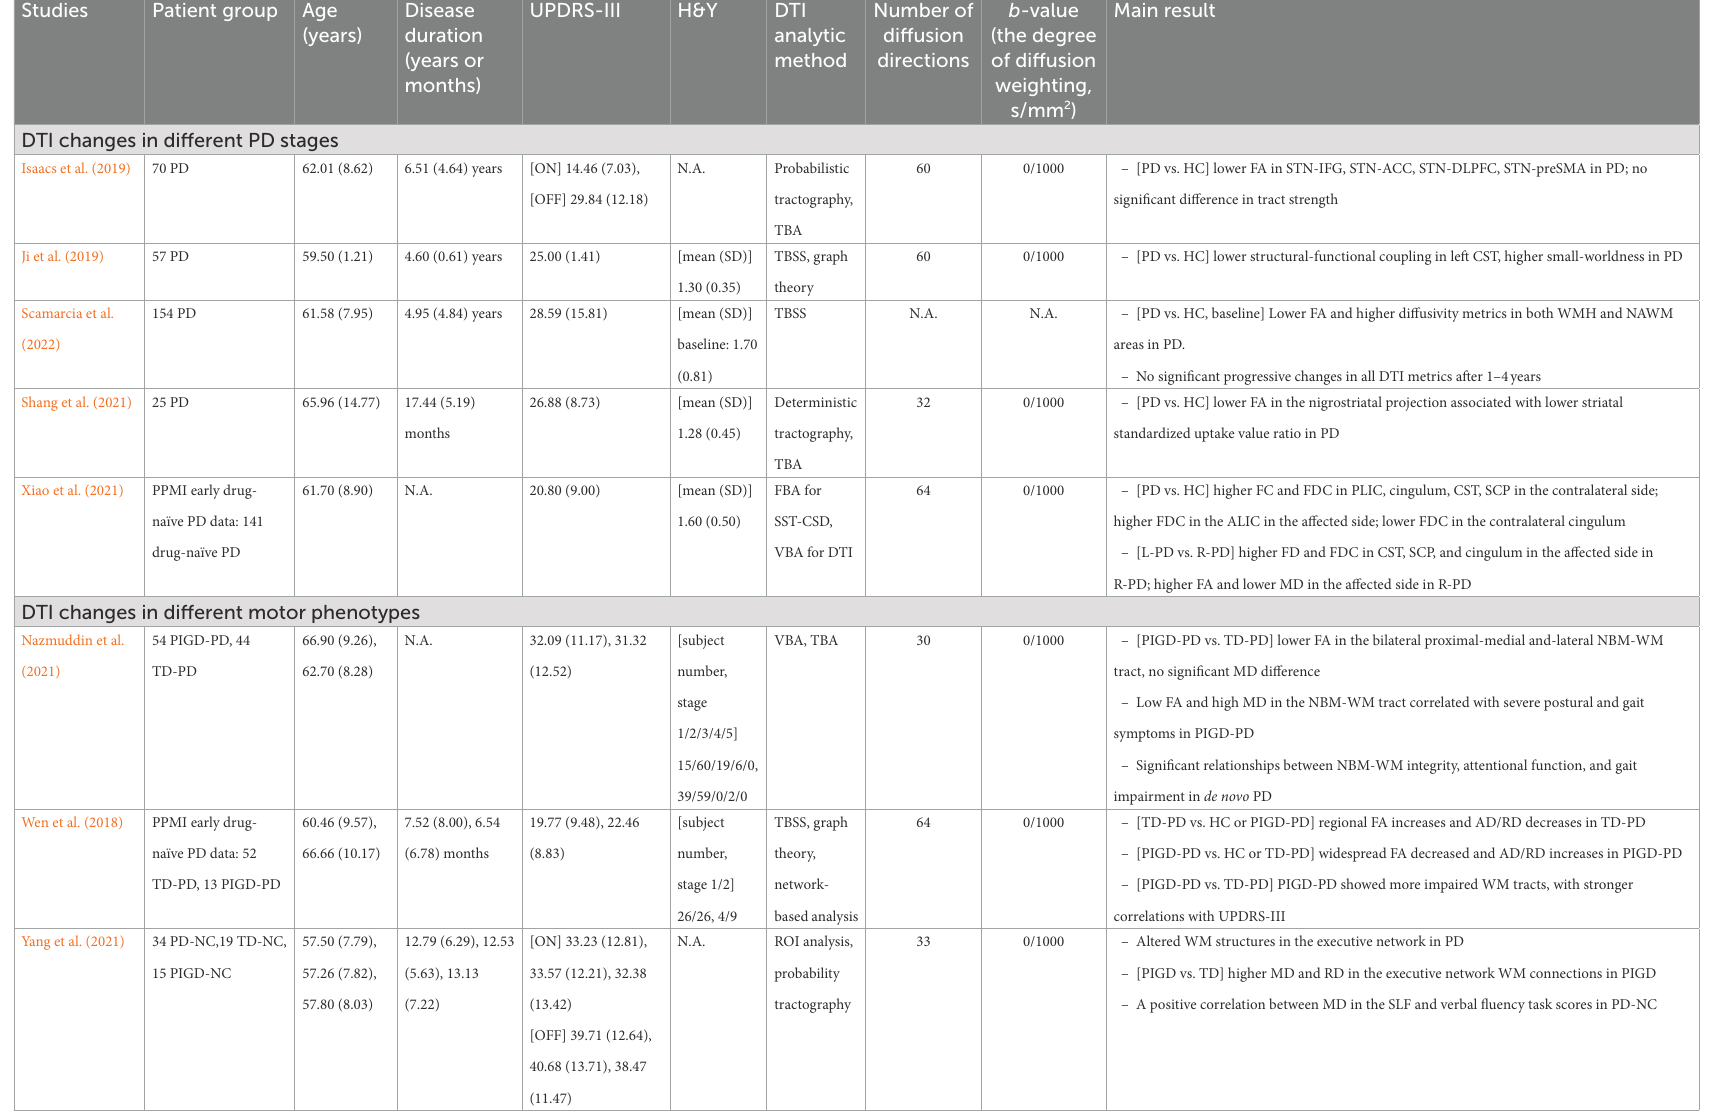
TABLE 1 Summary of diffusion tensor imaging studies in PD with different clinical conditions.